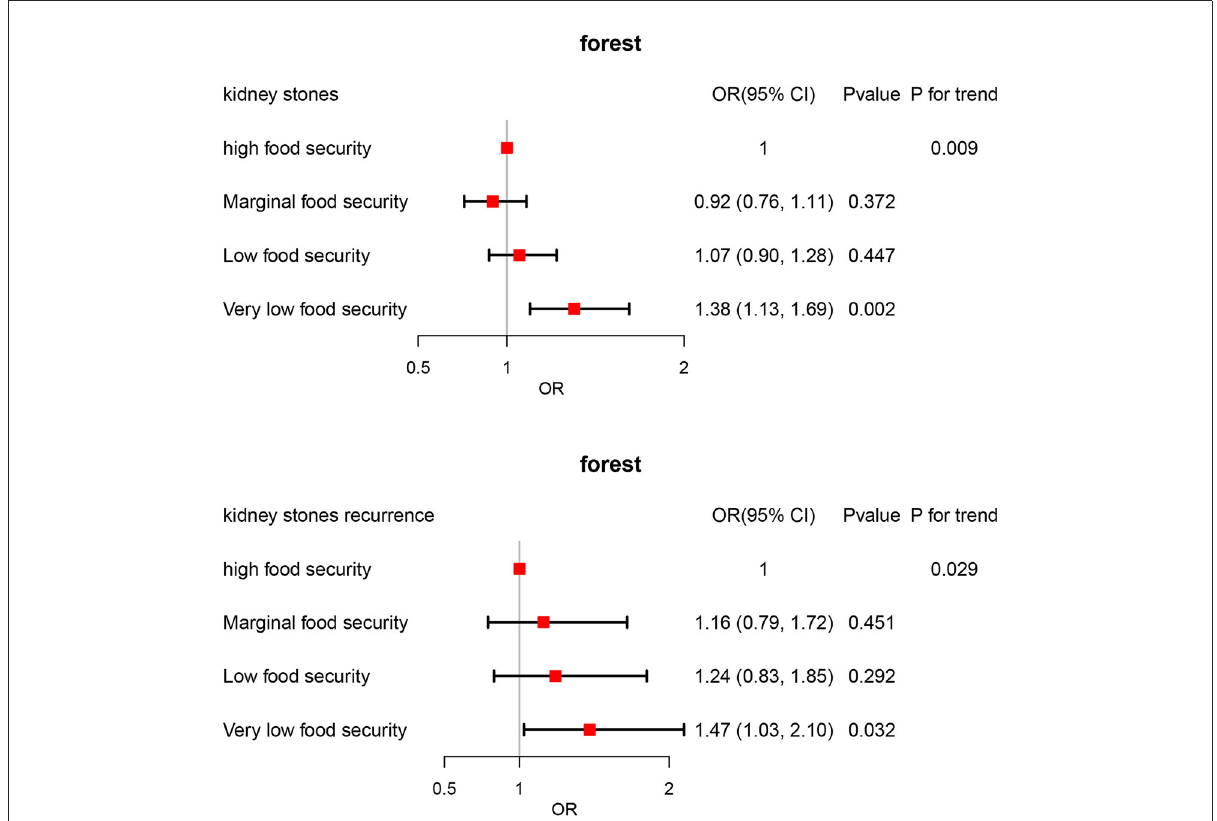
FIGURE2 ORs and 95% CIs for kidney stones associated with food